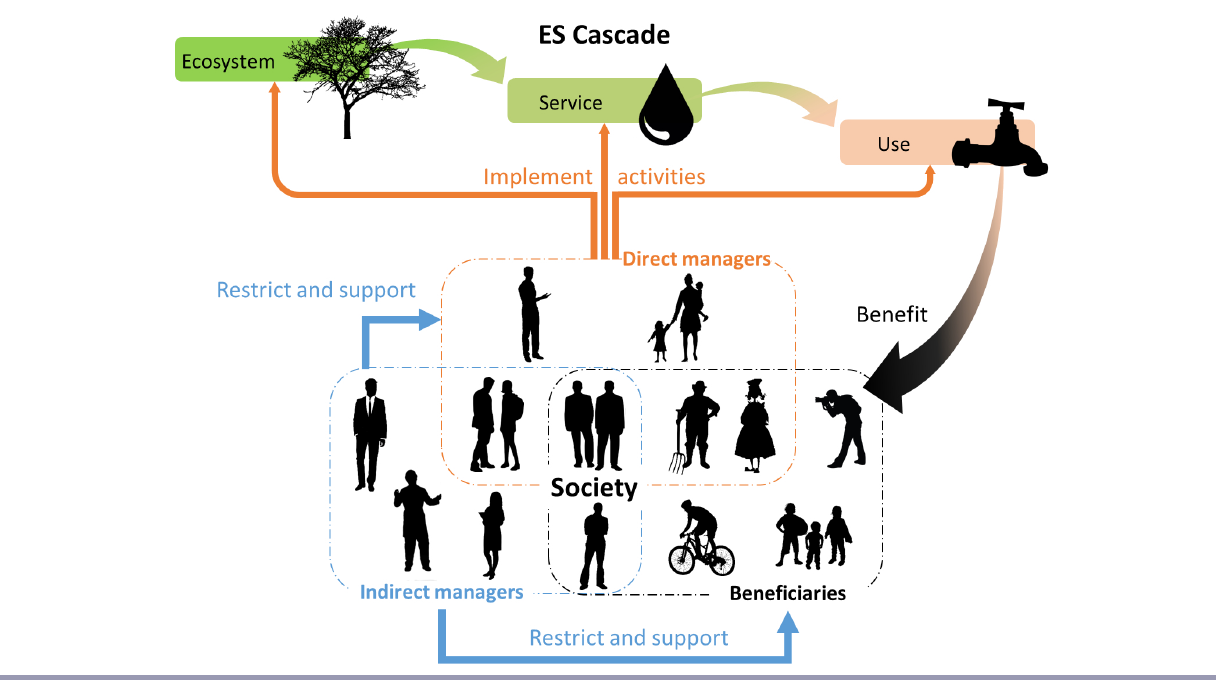
Fig. 1 . Analytical framework. Two forms of ecosystem service (ES) management, direct and indirect, can happen at three steps of the ES cascade: ecosystem, service, and